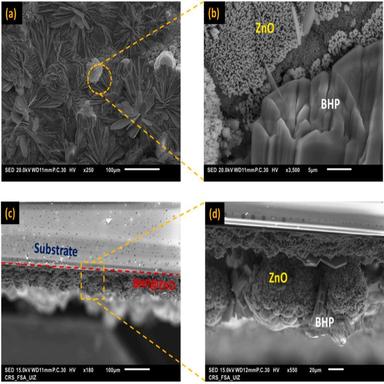
SEM analysis of ZnO@BHP thin film (a): Vertical view of the layer, (b): vertical view of a section at x 3500 magnification, (c): cross-sectional view of the layer, (d): cross-sectional view at x 550 magnification.